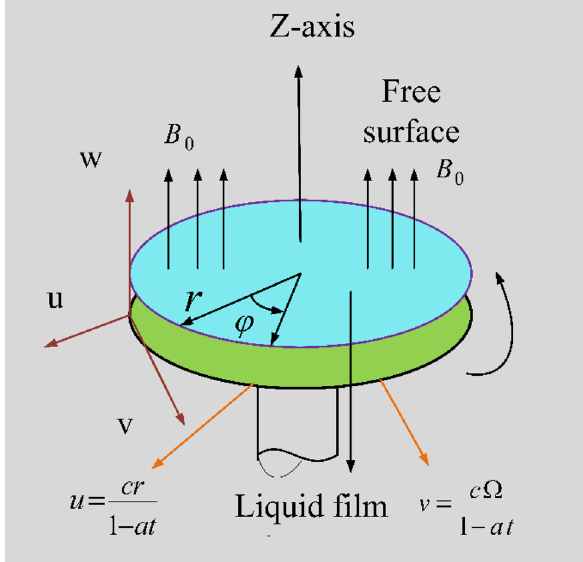
Figure 1. The geometry of the transient thin film flow